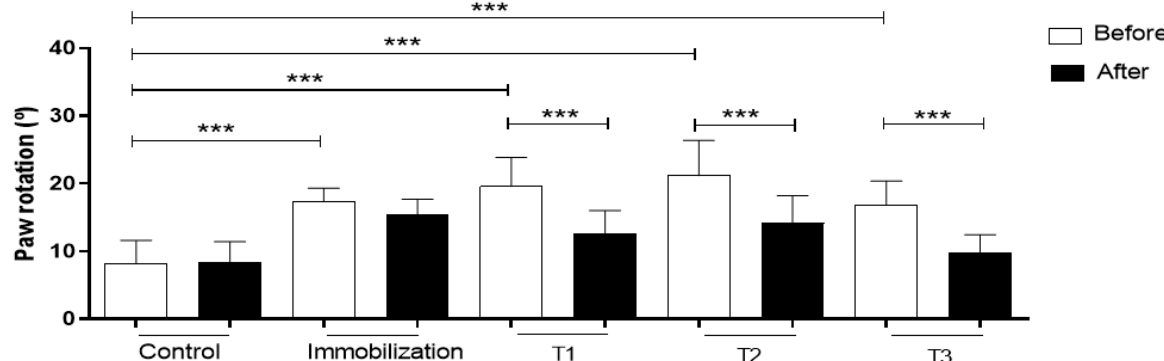
Figure 3. Comparative analysis of the rotation angle of the rats’ paws between and within groups before and after the use of EOAz with the use of the Paw Print Test. Where T1 (treatment 1), T2 (treatment 2) and T3 (treatment 3). ANOVA One-Way test with Tukey post-test, with *** p